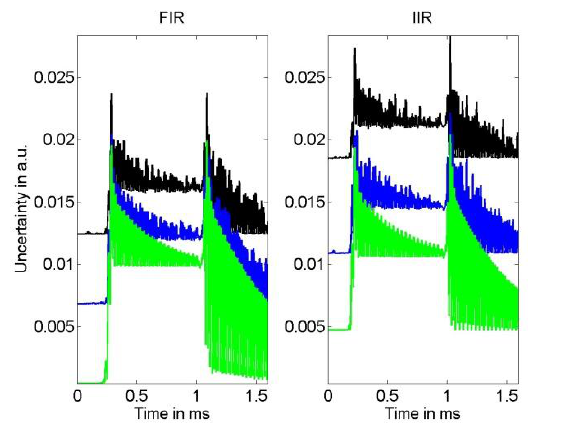
Figure 9. Left: Uncertainty associated with the FIR compensation filter result for three different noise values obtained for the broad-banded input. Right: Uncertainty associated with the IIR compensation filter